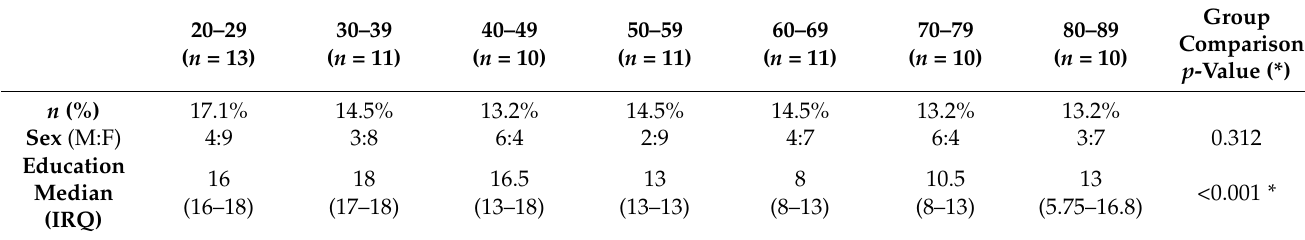
Table 3. Demographic characteristics of participants divided by the age